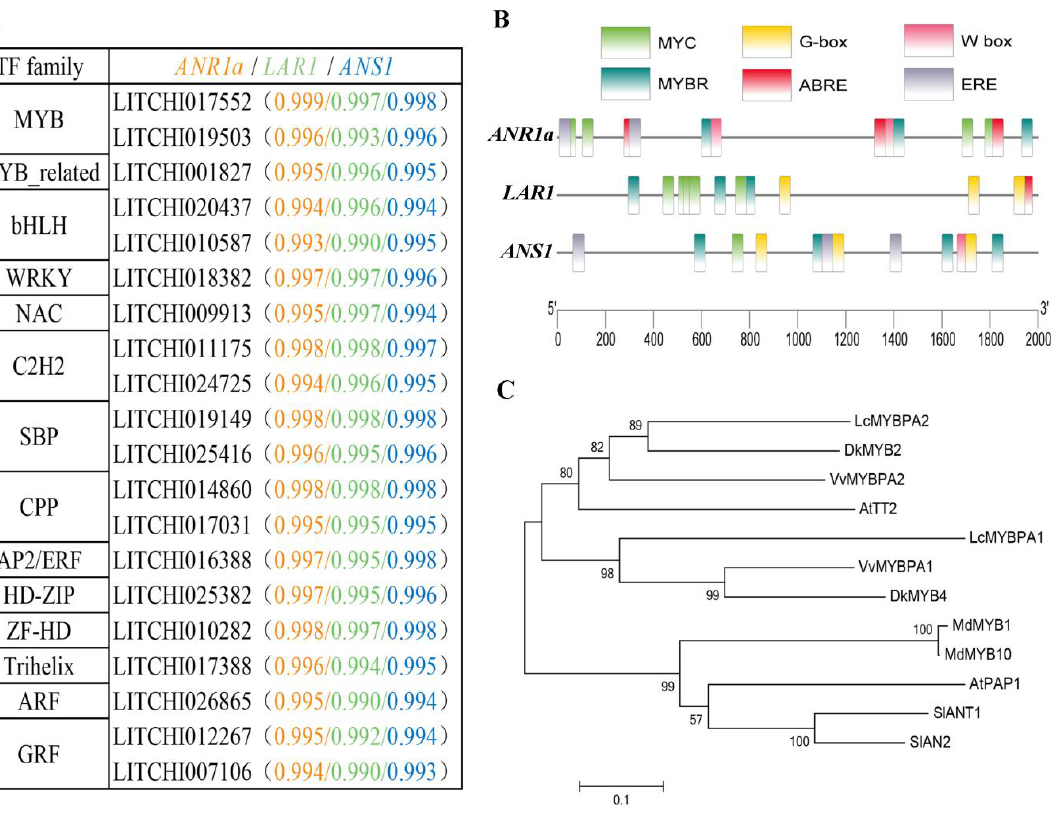
Figure 7. ( A ) The top 20 transcription factors (TFs) showing high correlation with PA biosynthesis